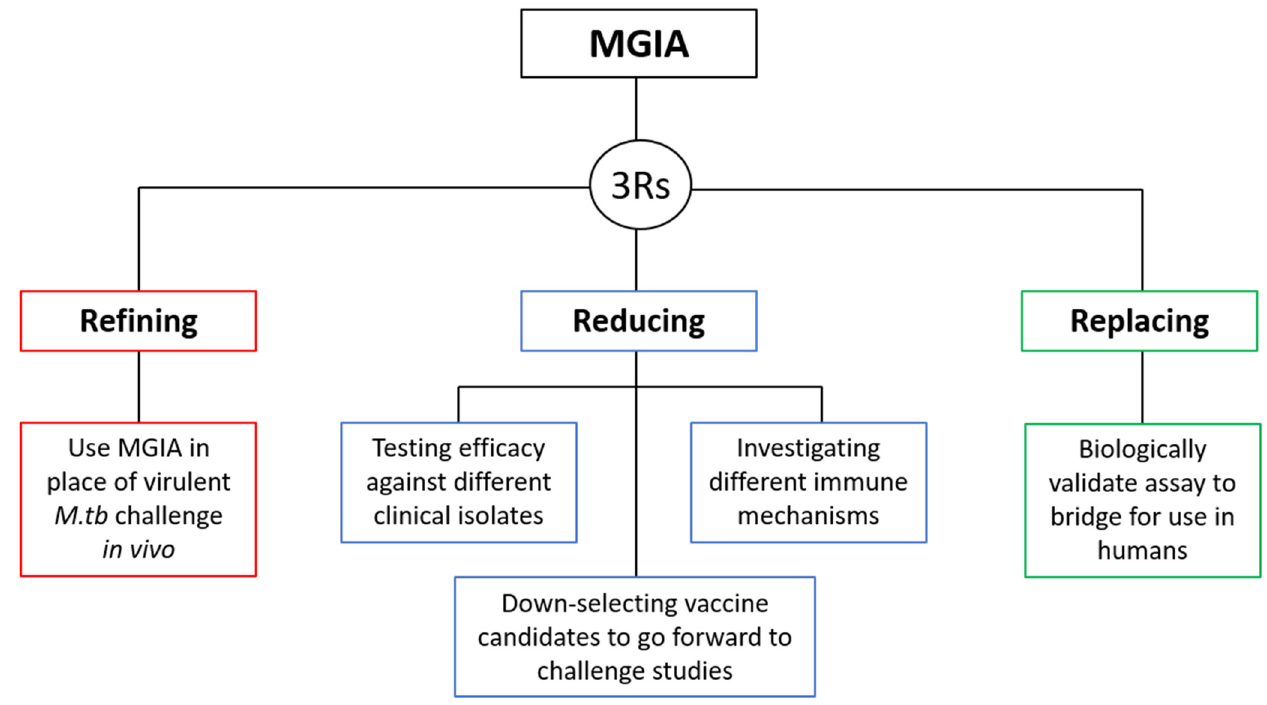
Figure 1. The 3Rs relevance of the NHP MGIA.